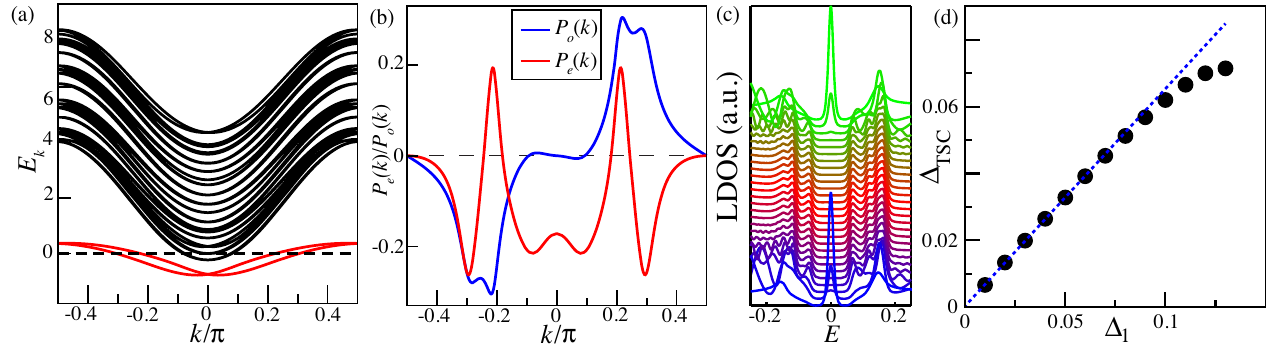
FIG. 5. Quasi-1D TSC in the general region of mixed parity. (a) Normal state band dispersions in the (1,1) direction in the 2D system ffiffiffi p 2 with L and large L D ¼ L so that k is continuous. The red lines correspond to the impurity bands and the black lines to ¼ 10 ð 1 ; − 1 Þ ð 1 ; 1 Þ the bulk bands. (b) Expectation values of the pairing order parameters with both even-parity ( P e ) and odd-parity ( P o ) components along the RALD. (c) The LDOS spectra along the line cut through the RALD from one end (bottom) to the other end (top) taken at equal ffiffiffi p 2 spatial distance of 10 , with the exception that the second curve from the bottom and top corresponds to the points 5 ends. The RALD is embedded in a finite-size system along the (1,1) direction with L D ¼ 250 (d) The evolution of the topological gap Δ along the RALD as a function of the bulk SC gap Δ 1 while the other parameters are fixed. TSC Parameters used are μ 0 ¼ − 4 . 0 , μ d ¼ − 0 . 8 , t 0 2 ¼ 0 . 1 , t 1 ¼ 0 . 1 , Δ 1 ¼ 0 . 1 , Δ 2 ¼ Δ 0 2 ¼ 0 , α 1 ¼ 0 . 5 , and α 2 ¼ 0